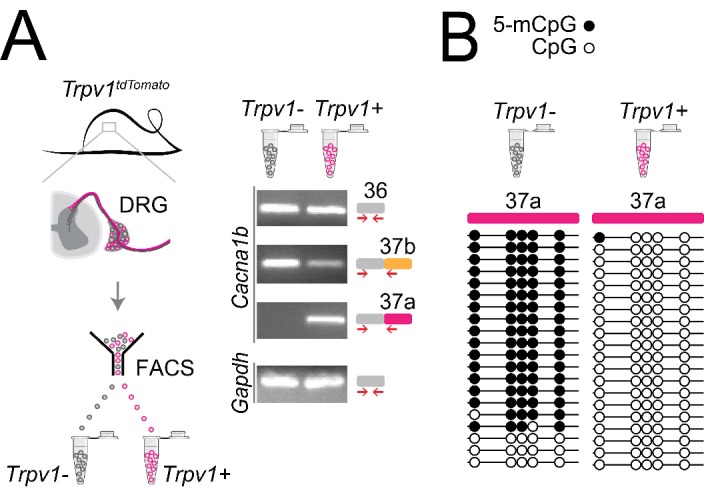
Cell-specific Cacna1b e37a inclusion and methylation in Trpv1-lineage nociceptors.(A) Trpv1Cre mouse strain crossed to lox-STOP-loxTdTomato expressed the TdTomato reporter in Trpv1-lineage neurons (Trpv1TdTomato). DRG cells were separated into Trpv1-lineage and non-Trpv1-lineage cells by fluorescence-activated cell sorting (FACS). Using specific primer pairs RT-PCR products amplified: constitutive Cacna1b e36, alternative spliced e37a and e37b, and Gapdh in Trpv1-lineage and non Trpv1-lineage cells for all primer pairs except for non Trpv1-lineage cells that failed to amplify from e37a-specific primers. Data shown are representative of a biological replicate from at least three different FACS-separated DRGs from three animals. (B) Methylation state of 5 CpG sites in Cacna1b e37a locus in non Trpv1-lineage (left) and in Trpv1-lineage neurons (right). Methylated (5-mCpG, filled circle) and unmethylated (CpG, open circle) sites are shown for independent clones ordered from most to least methylated. Each set of sequences represents data pooled from at least 10 FACS-separated DRG cells from one animal. These results are confirmed in Figure 7D for six additional animals.